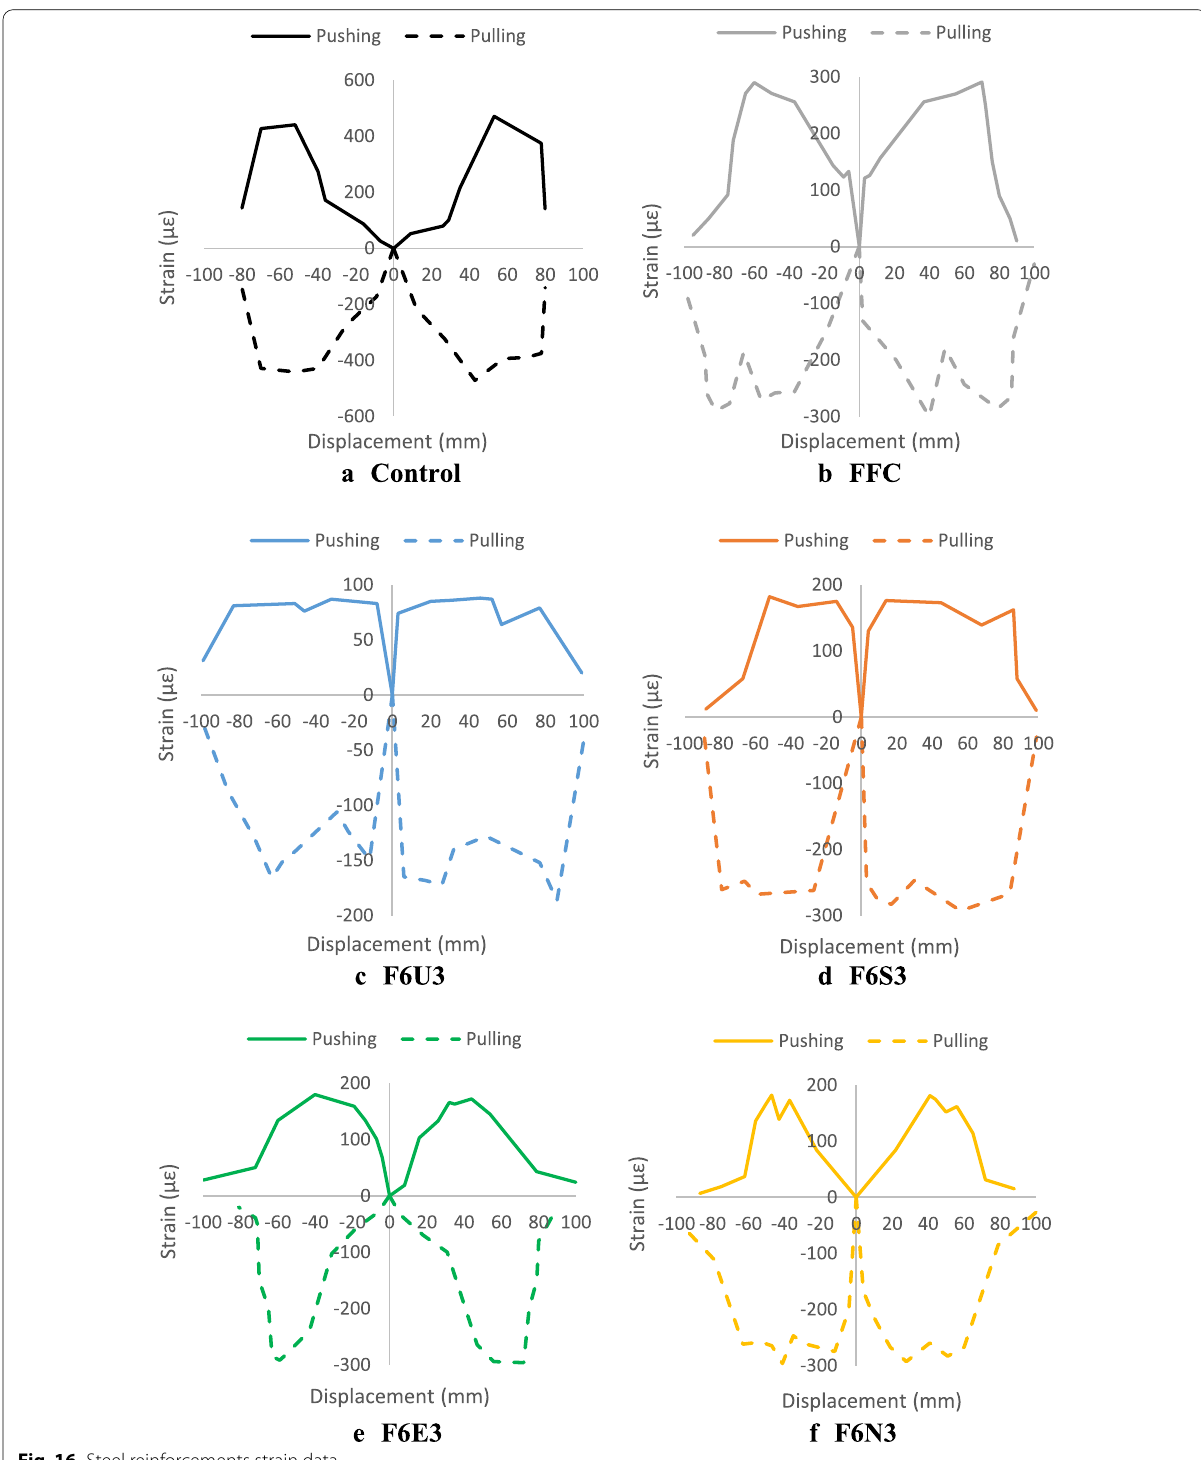
Fig. 16 Steel reinforcements strain